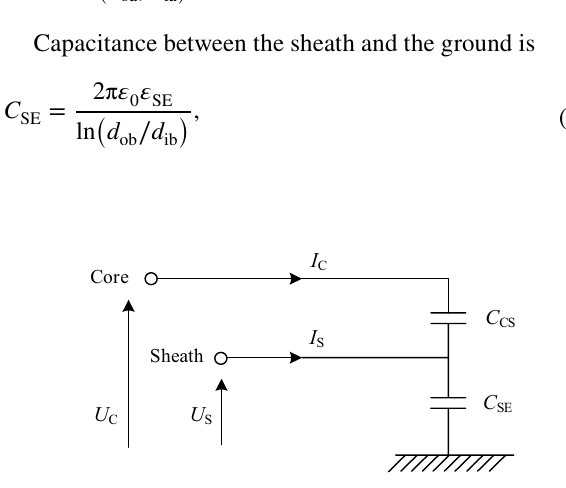
Fig. 8 Schematic diagram of capacitance of single-core